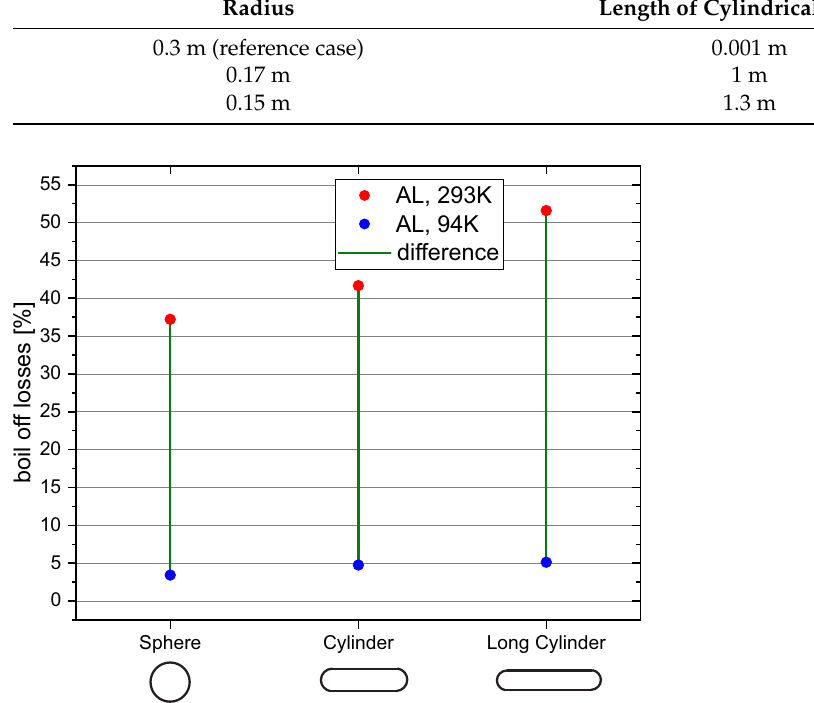
Figure 10. Relvative boil-off losses for different tank geometries.